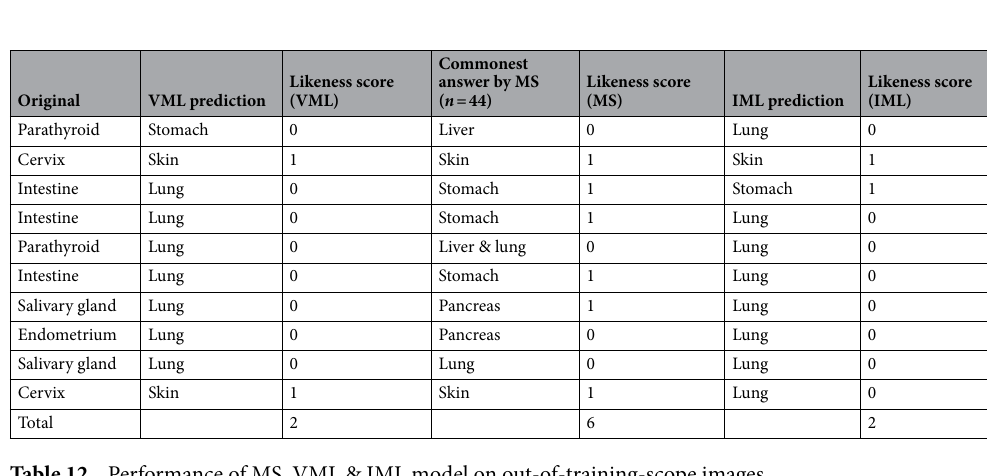
Table 12. Performance of MS, VML & IML model on out-of-training-scope images.